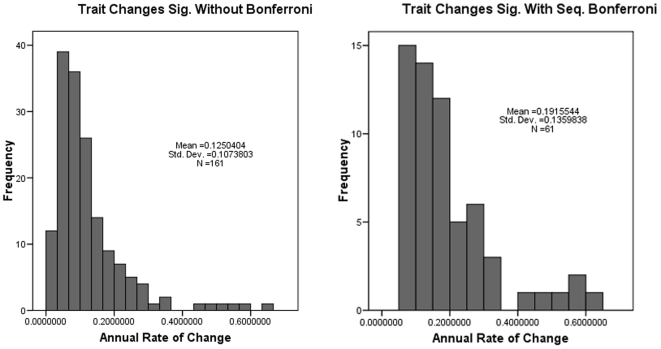
Histograms showing frequency distributions of significant trait changes before and after sequential Bonferroni correction.Left: frequency distribution of rates of annual changes significant before Bonferroni correction. Right: frequency distribution of rates of annual changes significant after sequential Bonferroni correction.